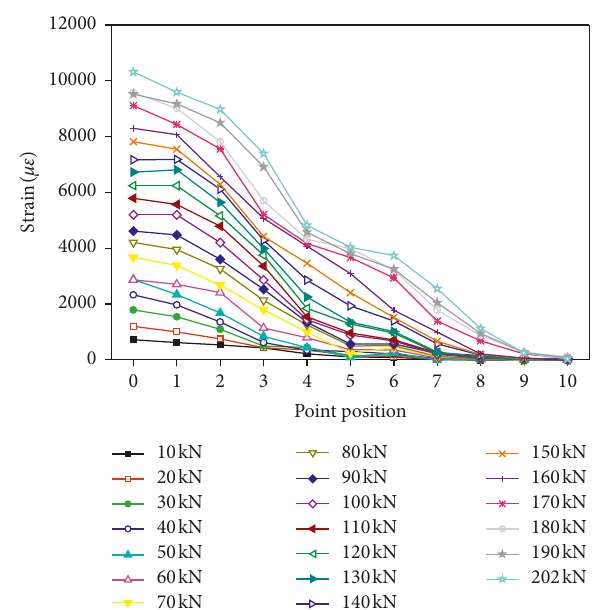
Figure 8: Single-load strain curves of GFRP bars under strong constraint